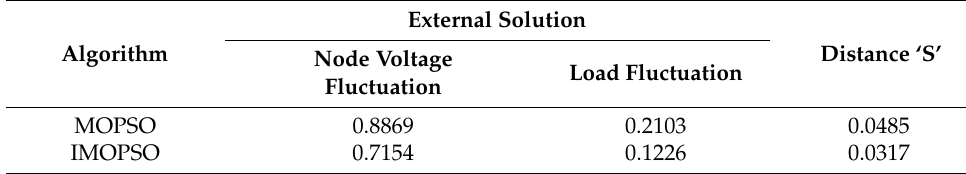
Figure 13. Convergence curves of external solutions for different objectives. Table 6. Algorithm performance